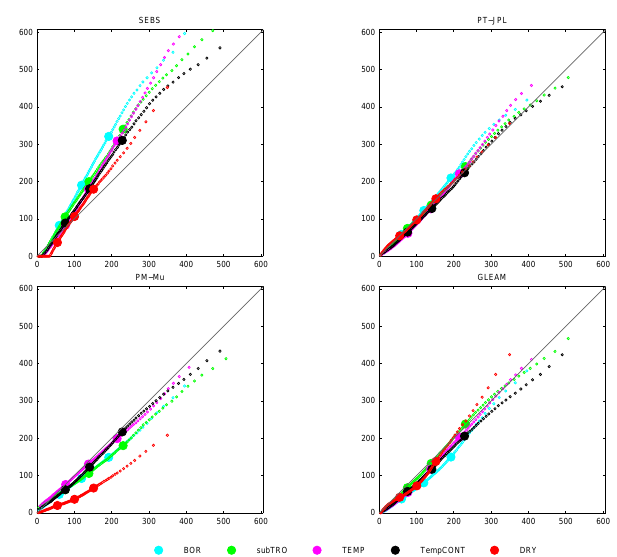
Figure 9. Percentile plots of observed ( x axis) vs. estimated latent heat flux ( y axis) at 3-hourly resolution for tower-based analysis and across the different climate zones. Percentiles encompass the 1st to 99th range in 1 percent increments. Q 25 , Q 50 and Q 75 are denoted by large circles.